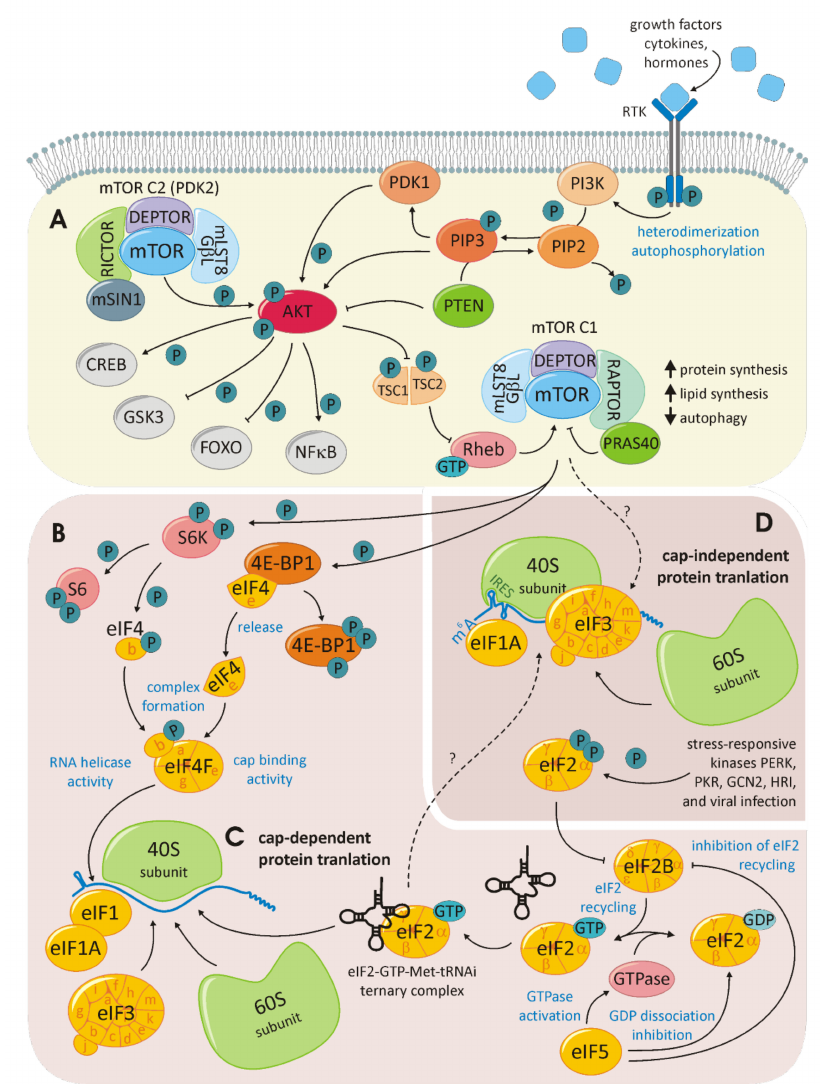
Figure 5. Crosstalk between mTOR and eIF signaling and possible targets for therapeutic